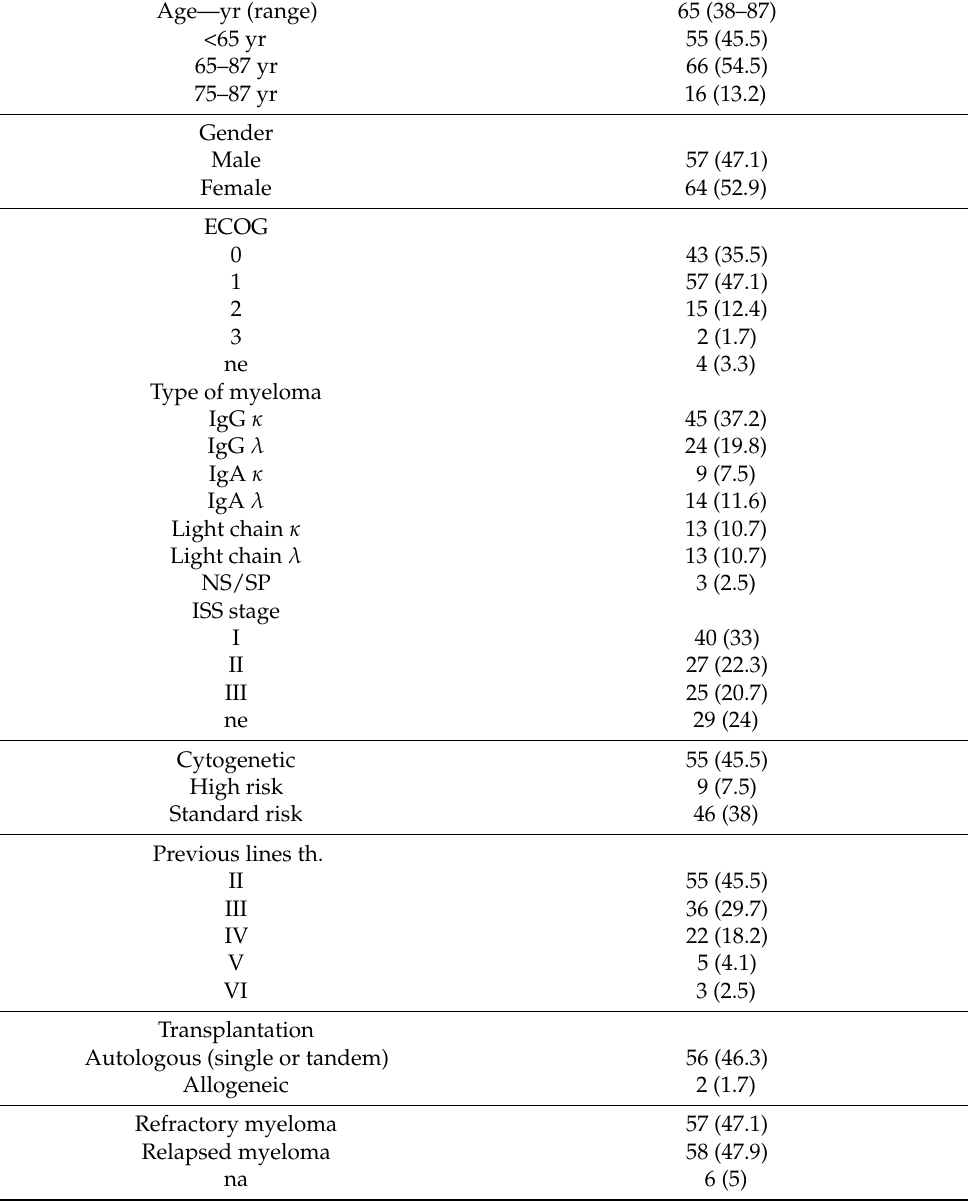
Table 1. Patients’ baseline characteristics †